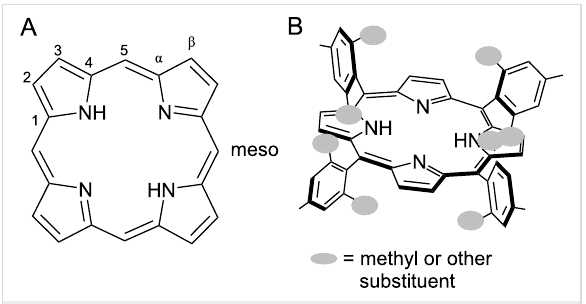
Figure 1: A) Porphyrin structure and labelling system. B) Substituents in the ortho -position of the group attached to the methane bridge create steric hindrance around the meso -position, above and below the plane of the porphyrin